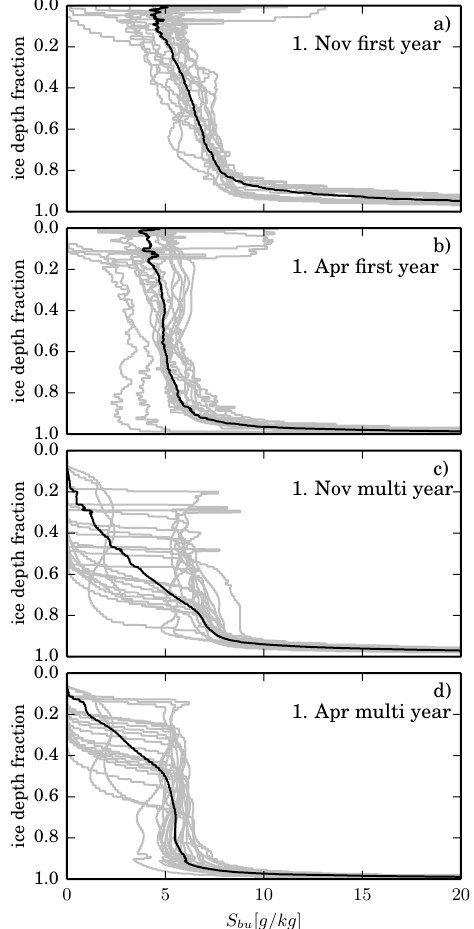
Figure 15. Vertically normalized salinity profiles of the reanalysis forced simulations (described in Sect. 4.1) using the complex salin- ity parametrizations on 1 November ( a and c ) and 1 April ( b and d ). First-year ice ( a and b ) and multiyear ice ( c and d ) are shown sep- arately. The grey lines are the individual model realizations and the black line is the average overall